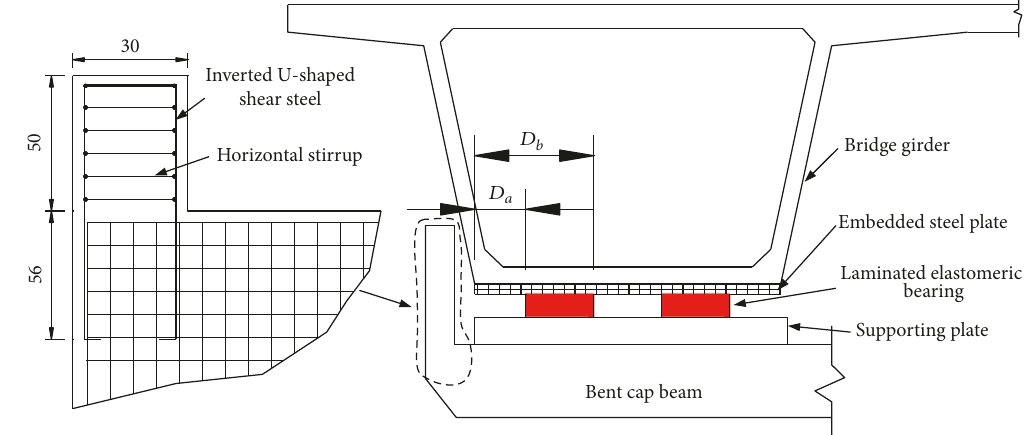
Figure 16: Details of arrangement of laminated elastomeric bearings and layout of shear key (unit: cm).